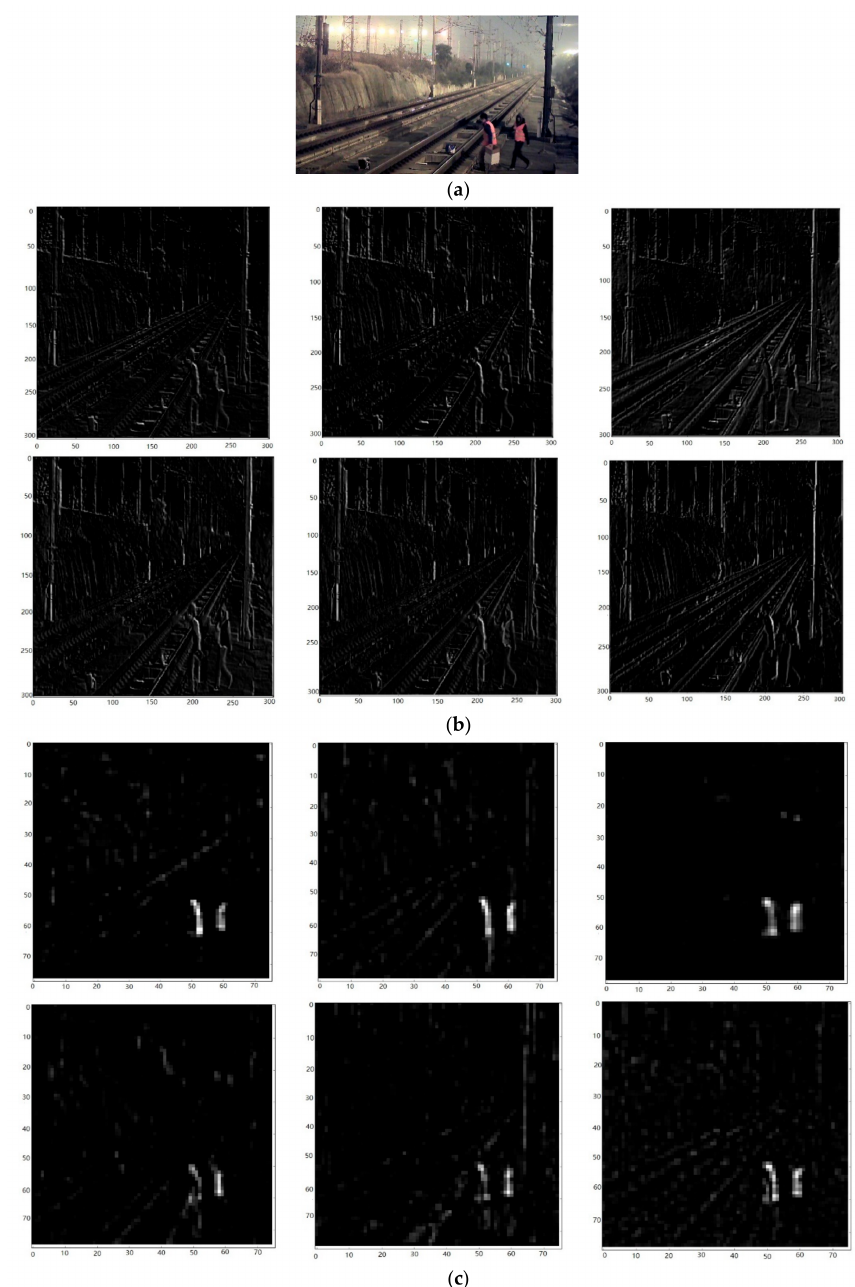
Figure 2. Feature maps of di ff erent feature layers. ( a ) Original Image. ( b ) Low-level feature map. ( c ) High-level feature